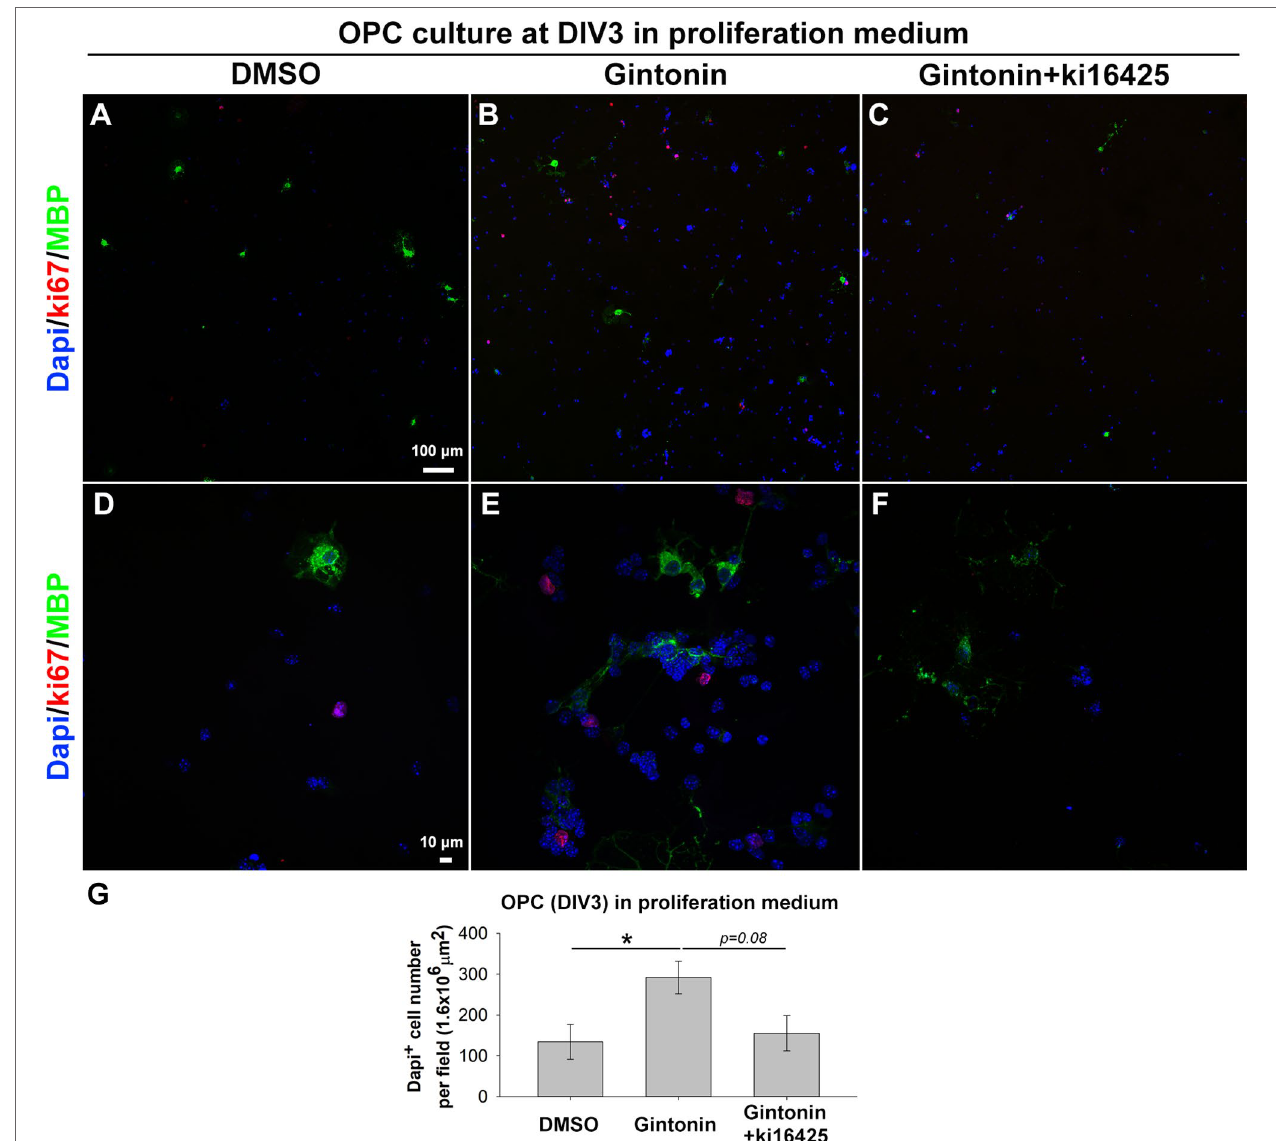
FIGURE 2 | Gintonin-induced proliferation is inhibited by Ki16425, a LPA 1/3 receptor antagonist. Pure OPC s were treated as indicated, with 10 μg/ml gintonin or 1 μM Ki16425 in the proliferation medium during DIV1–3 and fixed for proliferation analysis. (A – F) Cells were visualized by staining with DAPI (blue), antibodies to Ki67 (red), and MBP (green). Scale bars ＝ 100 (A – C) and 10 µm (D – F) . (G) DAPI + cell number was automatically counted per field by image J. Cell number was significantly increased by gintonin treatment (* p < 0.05) and showed a tendency of downregulation by Ki16425 treatment ( p = 0.08, one way ANOVA, Bonferroni post-test, N = 6–13). Bars represent mean ±